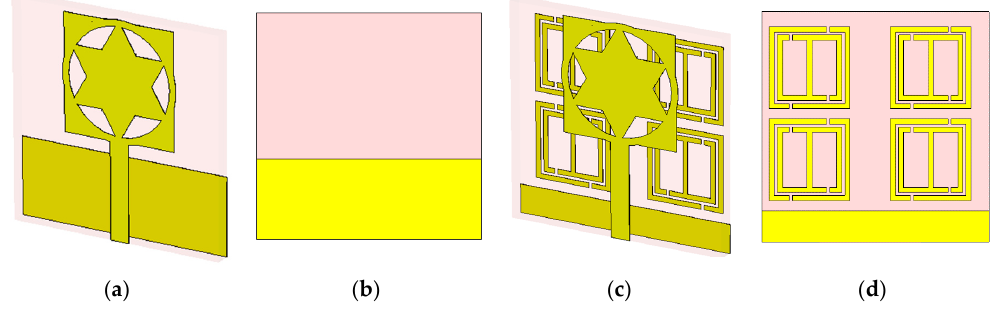
Figure 14. The geometry of the: ( a ) antenna transparent 3D view, ( b ) ground plane without integrated meta-atom back view, ( c ) antenna transparent 3D view of integrated meta-atom with ground plane, ( d ) ground plane replaced by integrated meta-atom, back view.